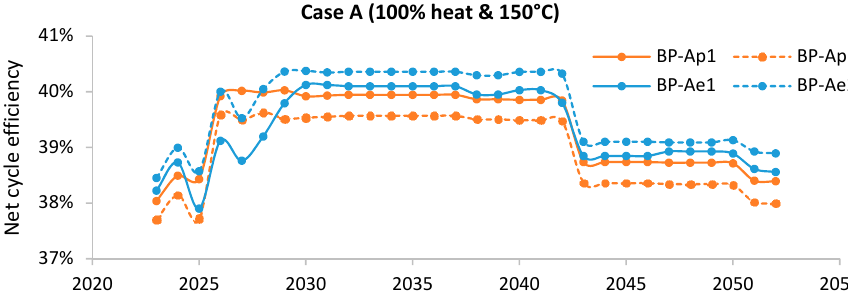
Figure 4. Performances of backpressure steam turbine cycles defined for case A.